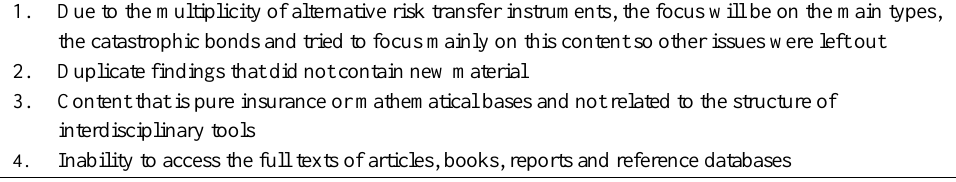
Figure 10- Research protocol